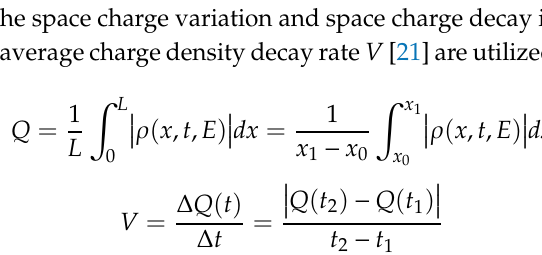
Figure 7. Space charge distribution of LDPE and h-BN / LDPE composites filled with h-BN: ( a ) 0, ( b ) 1, ( c ) 3, ( d ) 5, and ( e ) 10 phr during a short